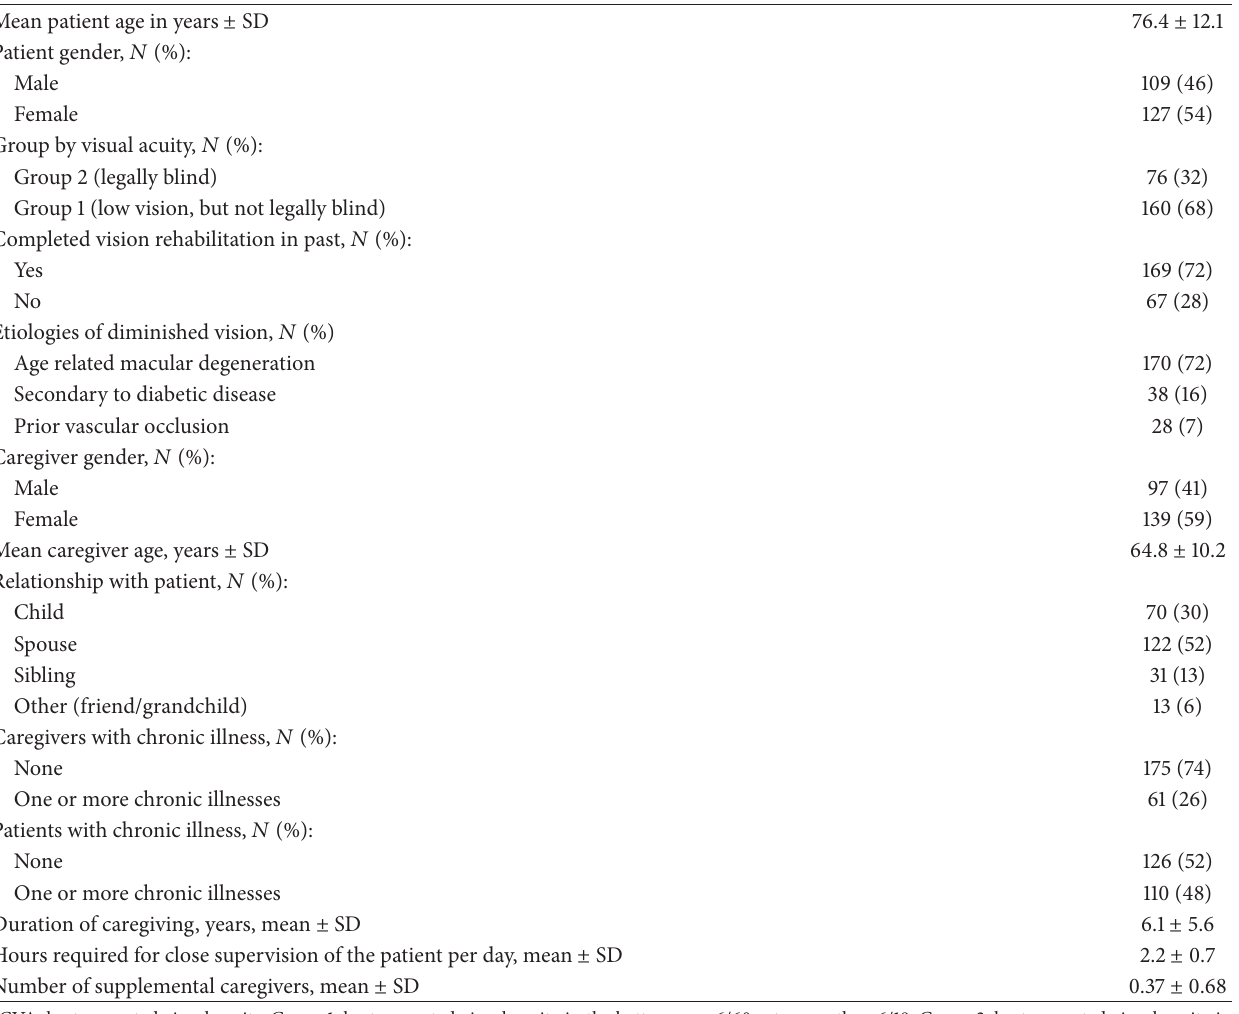
Table 1: Caregiver and patient characteristics, 𝑁 = 236